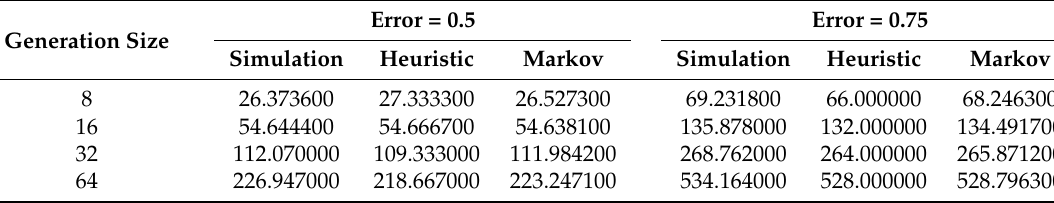
Table 2. Total number of transmissions in all links in cache coding.